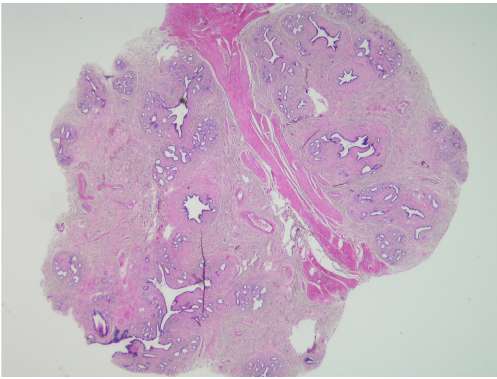
Figure 3: Result for immunohistochemical stain: di ff use epithelial stain for MFGP